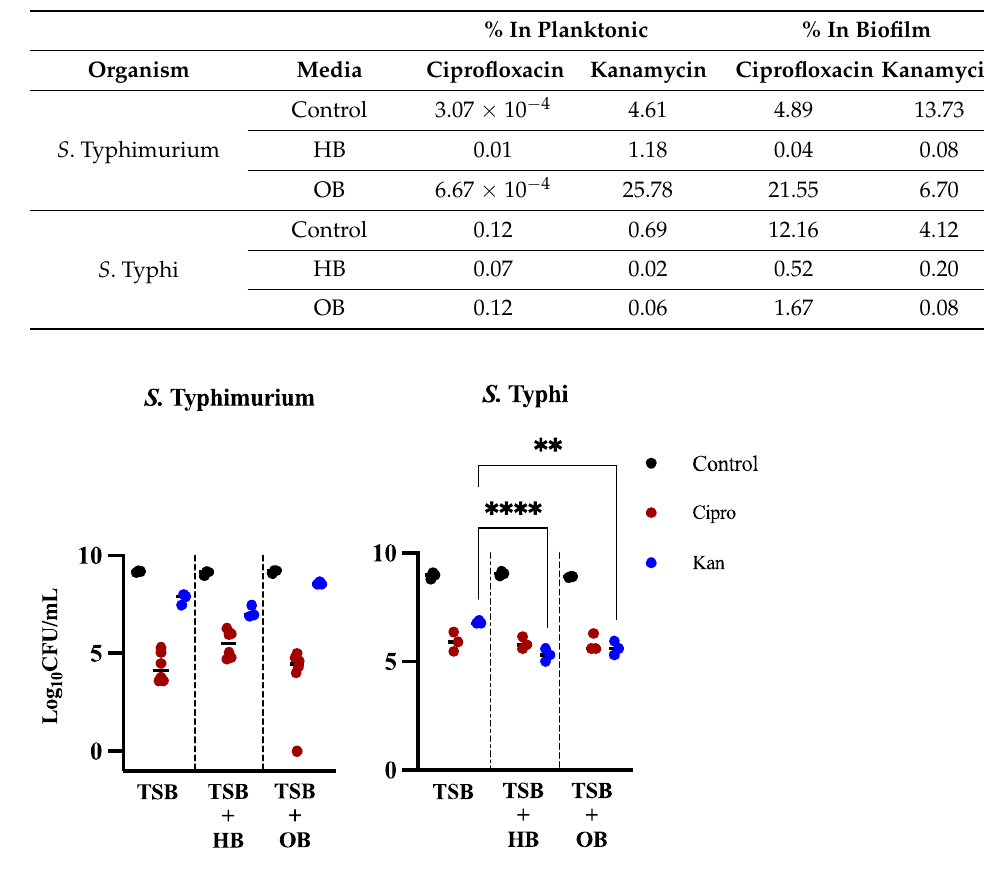
Figure 1. Persister cells recovered in S . Typhimurium 14028 and S . Typhi Ty2 laboratory strains after treatment with ciprofloxacin (red circles) or kanamycin (blue circles) in planktonic cells growing in ox bile (OB) or human bile (HB) versus total cells (strains not treated with antibiotics are represented by black circles). Representative charts are shown from one experiment performed with four or more bi- ological replicates and repeated at least three times with similar results. A one-way ANOVA followed by Tukey’s multiple-comparison test were used to compare the different conditions (**, p ≤ 0.01; ****, p ≤